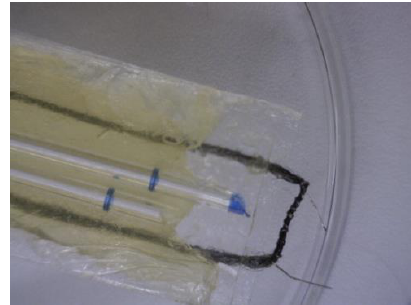
Figure 2. Fiber bundle and coil system shown loaded with lanolin. The fiber bundle is sandwiched between two glass slides and the capillary tubes are used to create a space between the slides in order to maintain a reservoir of lanolin. The coil and a section of the fiber bundle is maintained free from direct contact with the lanolin in order to minimize flow of material directly to the coil from outside of the fiber bundle